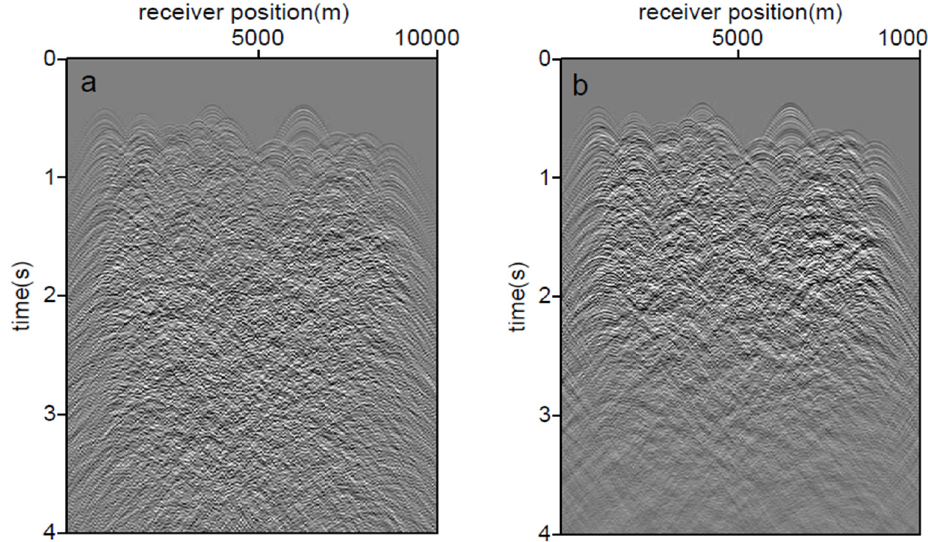
Figure 2. Noise signals recorded from the acoustic ( a ) and visco-acoustic ( b ) simulations.